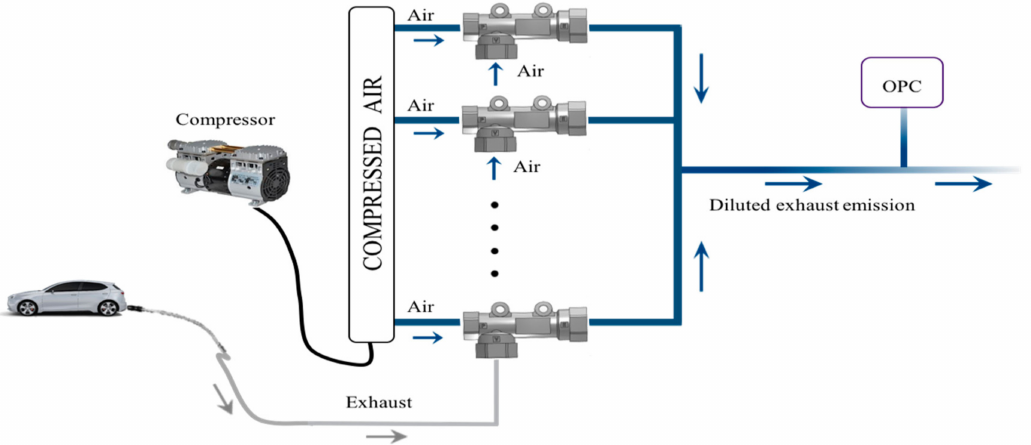
Figure 5. Layout of the system after the exhaust using parallel